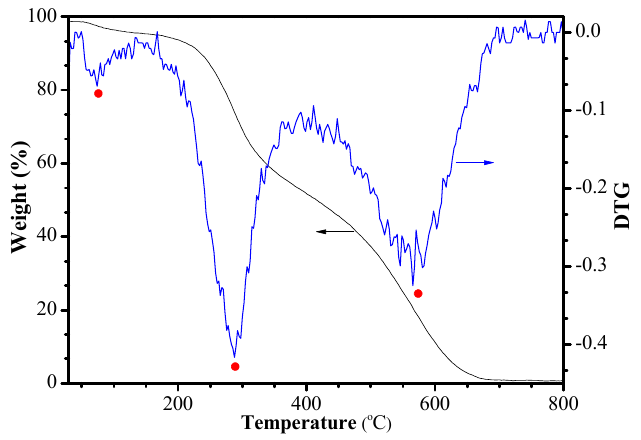
Figure 2. TG and DTG curves of CGC.